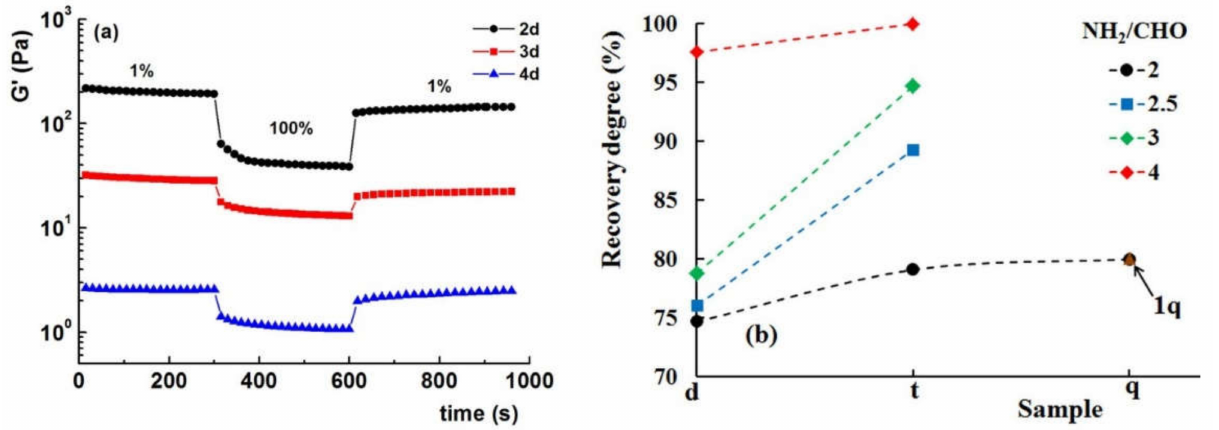
Figure 9. ( a ) Effect of NH 2 /CHO ratio on the structure recovery ability determined by the continuous step strain measurements (1–100–1%) at = 10 rad s − 1 and ( b ) recovery degree of samples with various dilutions and NH 2 /CHO